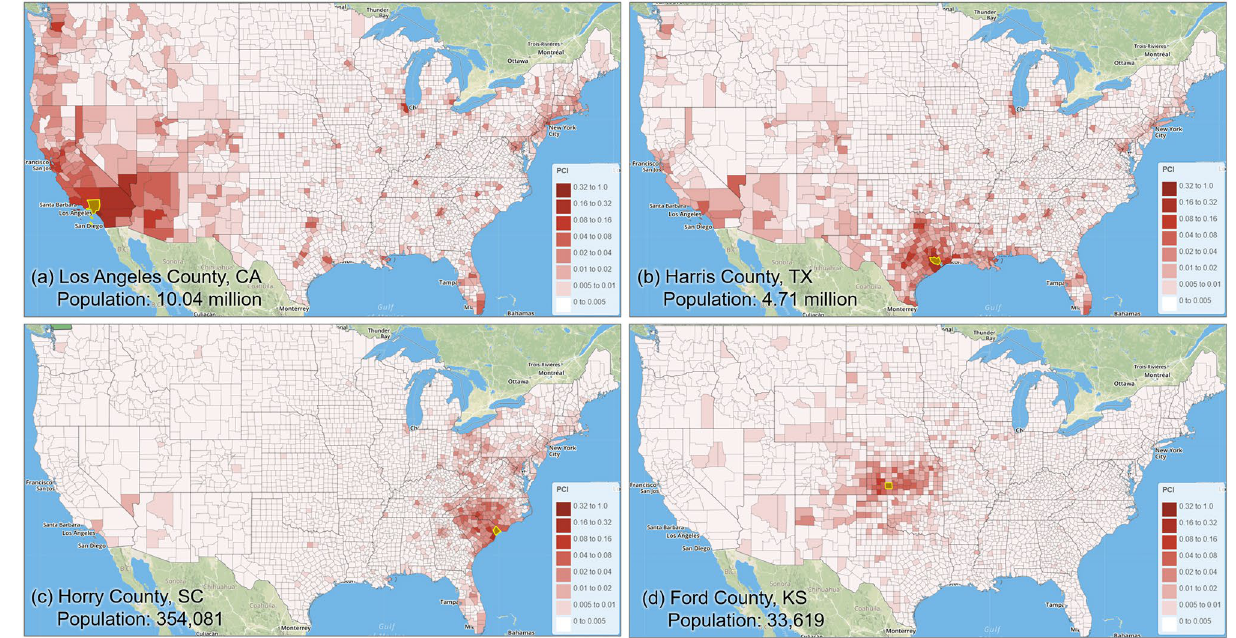
Figure 10. The selected four counties (highlighted with yellow boundaries in the maps) and their PCIs with other counties in the contiguous US. Population data were derived from ACS 5-year Data (2015–2019). The PCI maps were generated by the web portal developed by the authors using Leaflet (version 1.7). The base map is from OpenStreetMap contributors, licensed under the Open Data Commons Open Database License (ODbL) by the OpenStreetMap Foundation (OSMF). https:// www. opens treet map. org/ copyr ight.